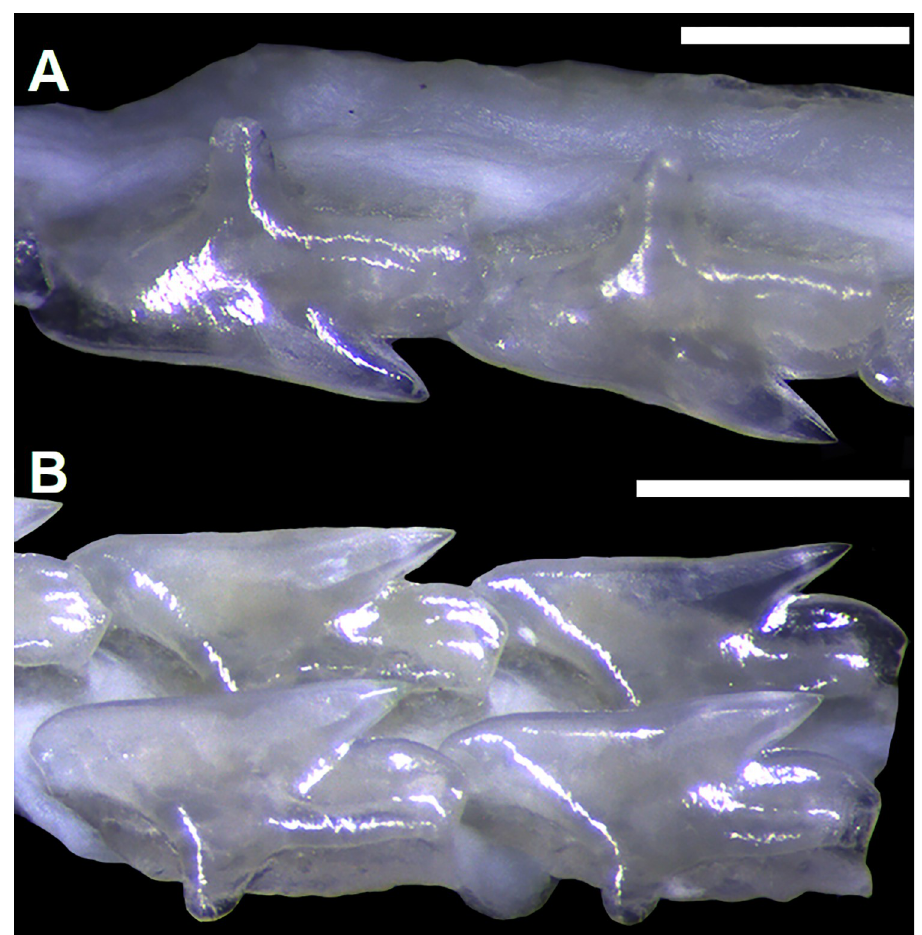
Fig 28. Upper (A) and lower (B) teeth (labial view) of C . australis , AMS I 45670–001, juvenile male, 630 mm TL. Scale bars: 1 mm. (9.0%–10.5%) TL; second dorsal-fin anterior margin convex and large, its length 14.2% (13.5%–14.9%) TL; second dorsal-fin posterior margin strongly concave, falcate (half-moon shaped in juveniles); second dorsal-fin height 1.7 (1.5–2.2) times greater than second dorsal- fin inner margin length; second dorsal-fin inner margin also short, its length 5.5% (4.4%– 6.3%) TL. Second dorsal-fin spine convex and broad, its base width 1.1% (0.8%–1.3%) TL, con- spicuously elongate, its length 6.4% (4.4%–9.3%) TL; second dorsal-fin spine corresponding to 1.1 (0.7–2.1) times length of first dorsal-fin spine and three-forth the height of second dorsal fin, exceeding the fin apex in juveniles only. Pectoral fins narrow (Fig 30A), although broader posteriorly than anteriorly, its base length 5.0%, (4.4%–5.8%) TL; pectoral-fin anterior and inner margins markedly convex; pectoral-fin posterior margin slightly concave, its length never greater than the trunk height when adpressed laterally, corresponding to 0.6 (0.6–1.7) times trunk height; pectoral-fin apex and free rear tips rounded and wide (sometimes lobulate in paratypes) with apex transcending hor- izontal line traced at pectoral-fin free rear tip; pectoral-fin anterior margin length 1.5 (1.2–1.9) times pectoral-fin posterior margin length, and 1.8 (1.6–2.0) times pectoral-fin inner margin length.